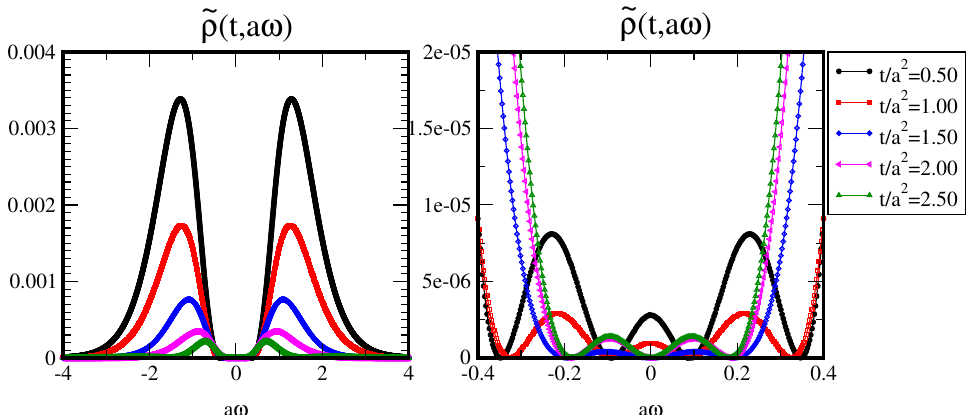
Figure 6 . The obtained spectral function ~ (cid:26) ( t; a! ) as a function of a! . The right panel is an enlarged plot in ! (cid:25) 0